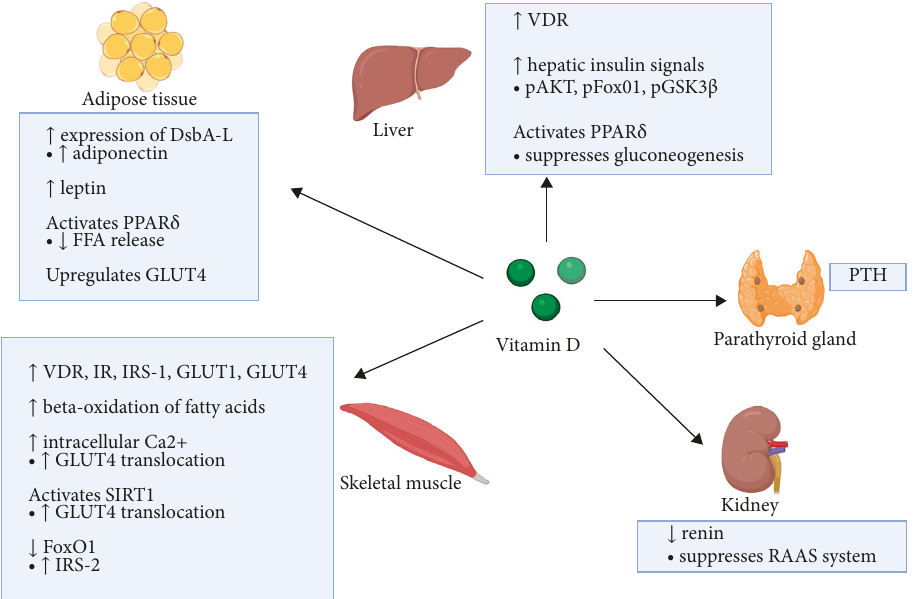
Figure 3: Schematic diagram summarizing the roles of vitamin D in maintaining insulin sensitivity. In the liver, vitamin D increases VDR expression, enhances hepatic insulin signals, and activates PPAR- δ to suppress hepatic glucose production. In the adipose tissue, vitamin D increases the production of insulin-sensitizing hormones adiponectin and leptin, activates PPAR- δ to reduce the release of FFA into the circulation, and upregulates GLUT4. In the skeletal muscles, vitamin D increases the levels of VDR, IR, IRS-1, GLUT1, and GLUT4, enhances β -oxidation of fatty acids, increases intracellular calcium levels, and activates SIRT1 to enhance the translocation of GLUT4 to the plasma membrane for glucose uptake, and increases the level of IRS-1 by suppressing FOXO1. Vitamin D also suppresses the gene expression of renin, thereby preventing inhibitory effects of RAAS against insulin action in peripheral tissues. On the other hand, secondary hyperparathyroidism as a result of vitamin D deficiency could exacerbate insulin resistance by reducing the glucose uptake. Vitamin D could maintain insulin sensitivity by increasing calcium absorption and preventing the secondary elevation of